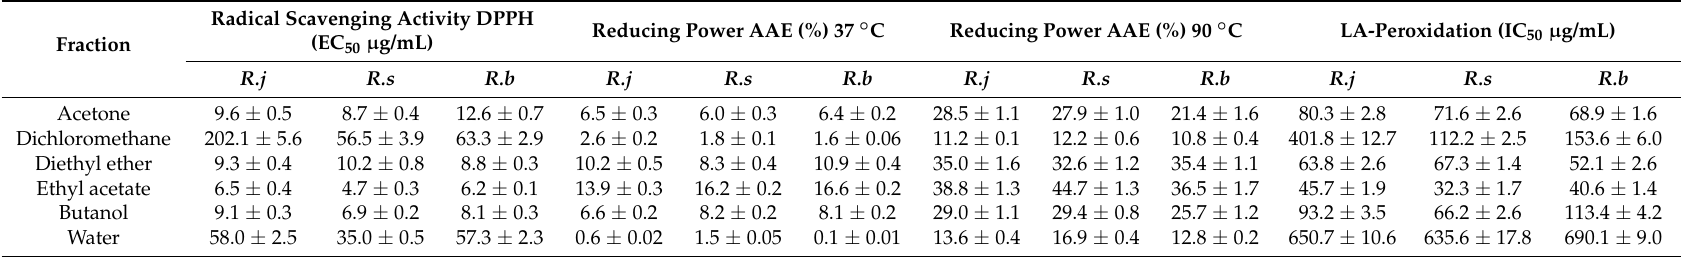
Table 2. Antioxidant activity of the studied extracts and